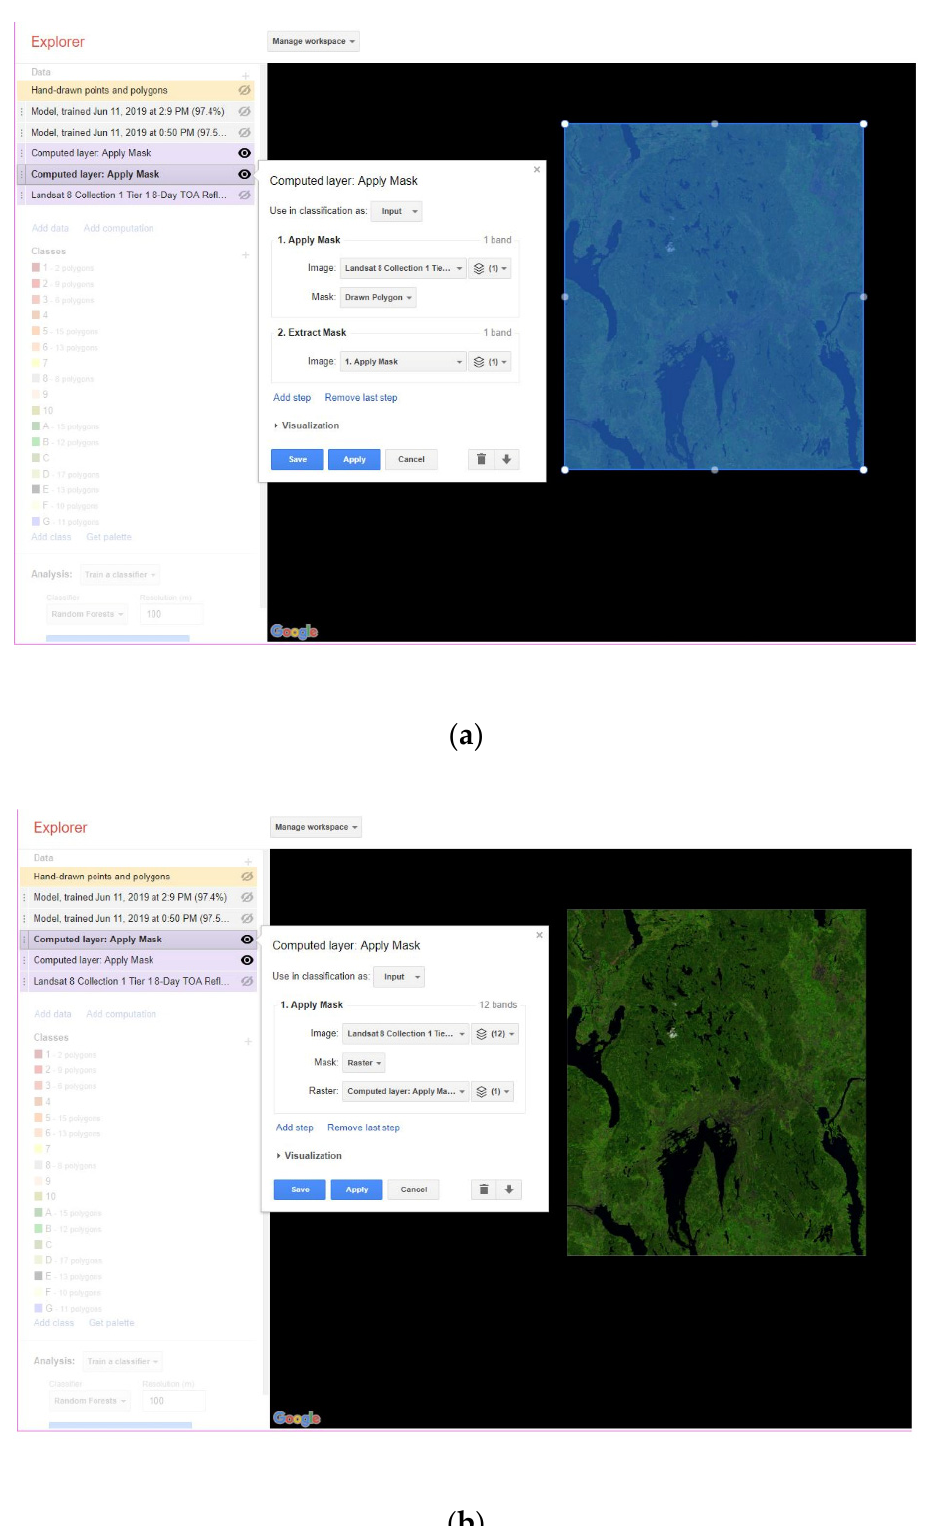
Figure 9. ( a , b ) Application of the masking area over the ROI shape to the Landsat 8 image in GEE.